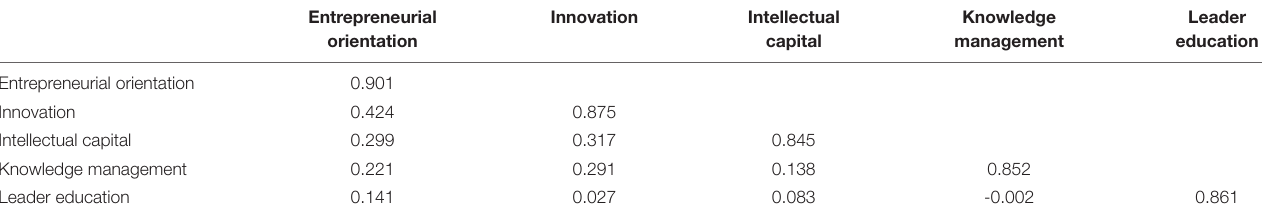
TABLE 3 | Fornell-Larcker criterion.